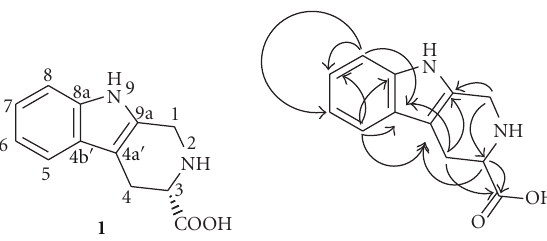
Figure 1: The structure of compound 1 and the key HMBC ( → :H → C)